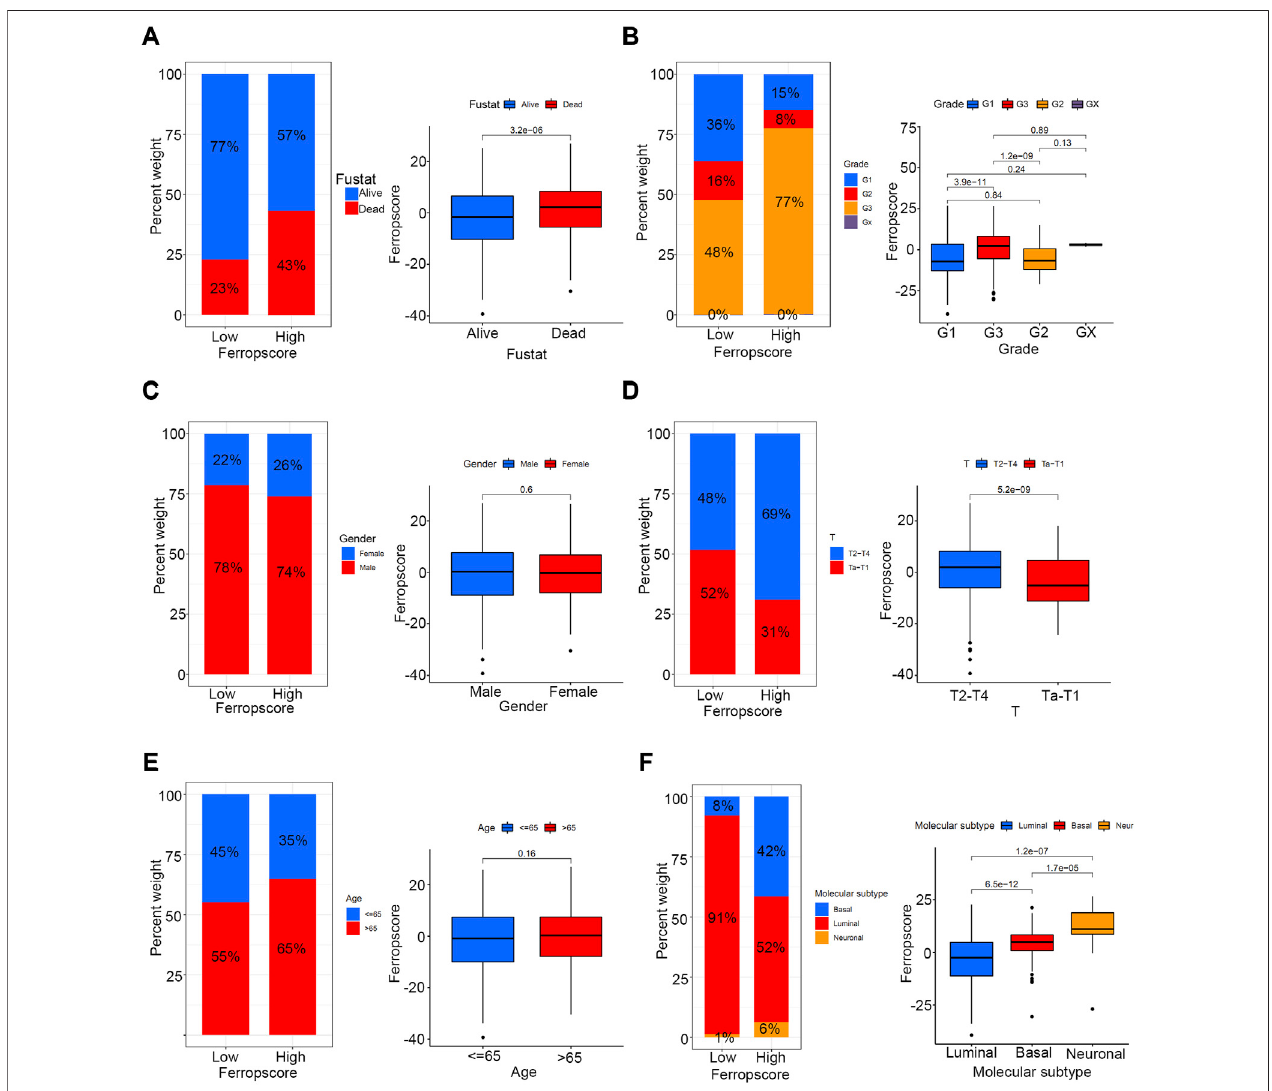
FIGURE 7 | Relationship between ferropscore and various clinical parameters including age, alive/dead status, sex, tumour stages, tumour grades and molecular subtypes of bladder cancer. (A) Relationships between ferropscore and alive/dead status. (B) Relationship between ferropscore and tumour grades. (C) Relationship between ferropscore and sex. (D) Relationship between ferropscore and clinical stages. (E) Relationship between ferropscore and age. (F) Relationship between ferropscore and molecular subtypes.